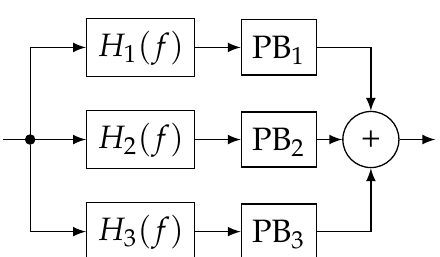
Figure 1. Block diagram for FBPB. ©IEEE. Reprinted, with permission, from [9].